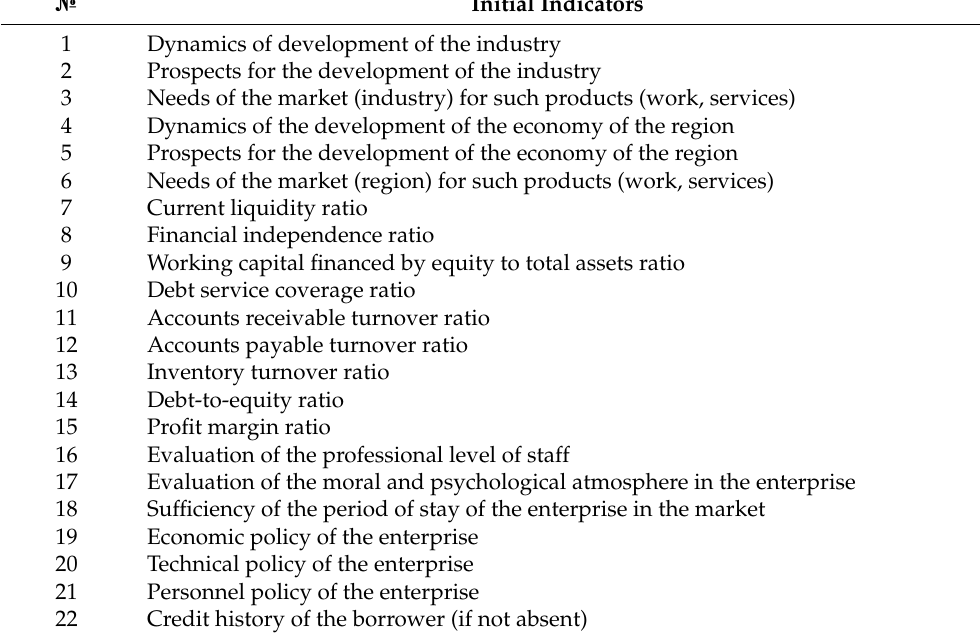
Table 1. Financial and general economic